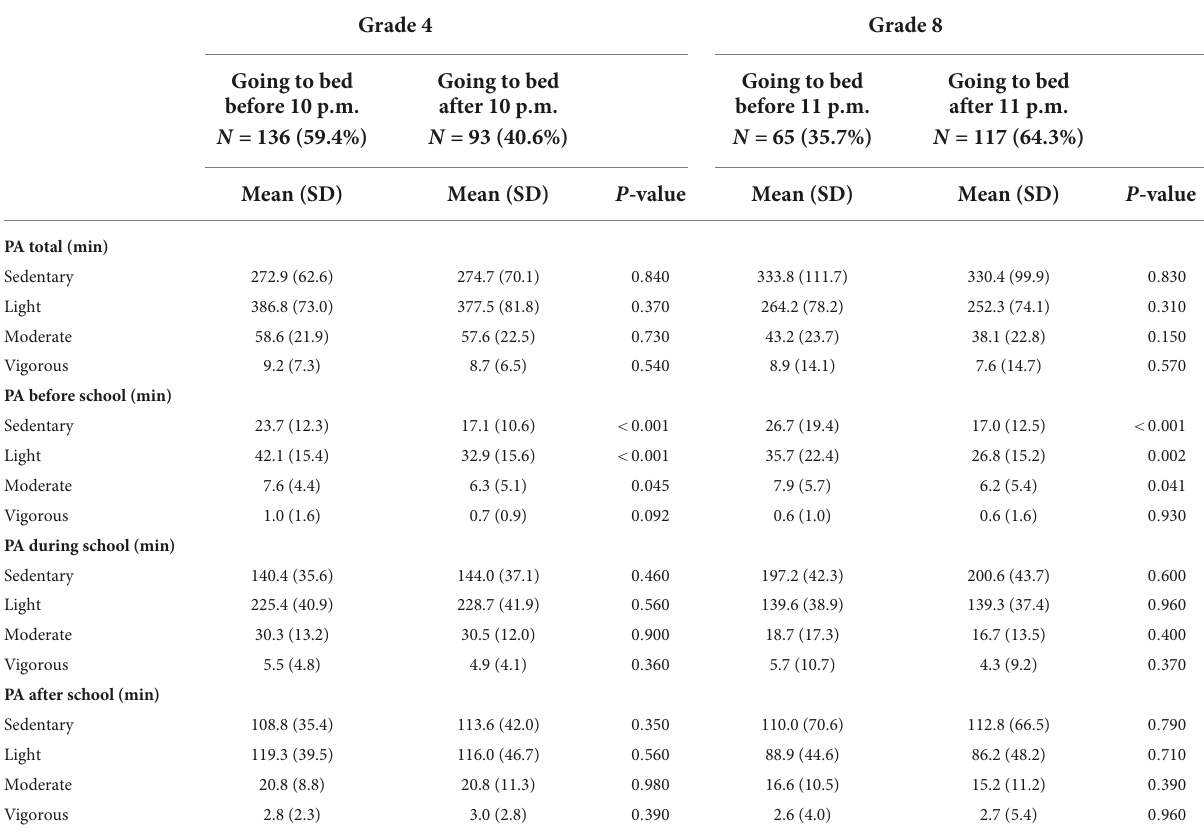
TABLE 2 Average physical activity by grade and sleeping habit.